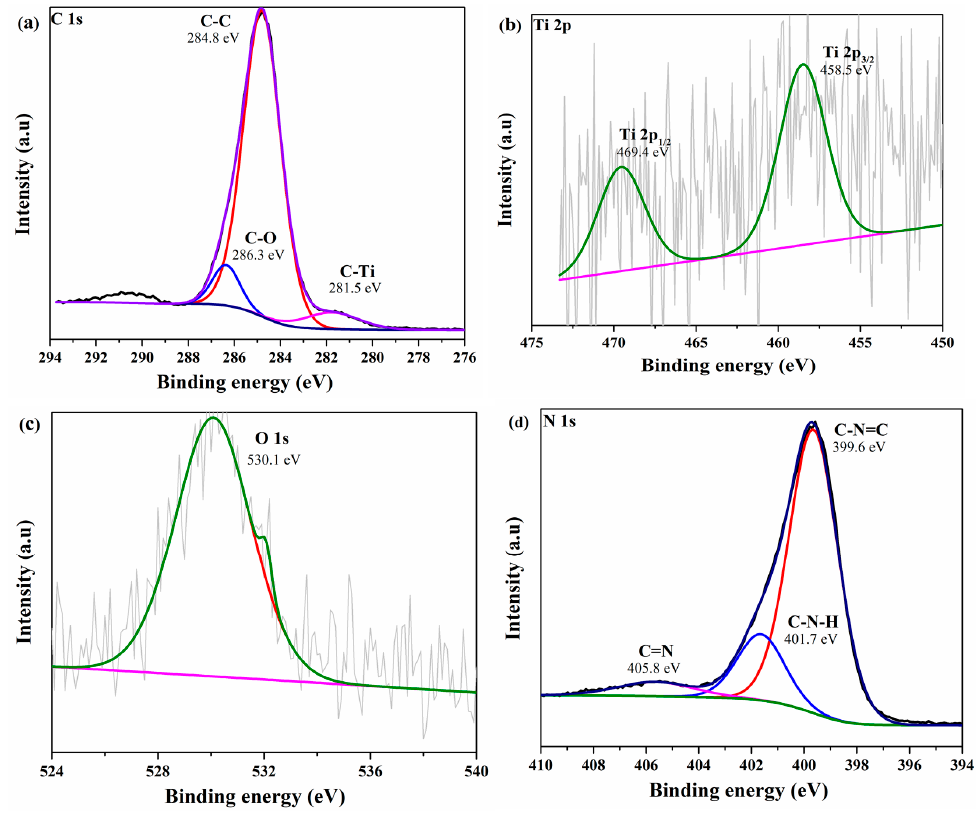
Figure 8. ( a ) C 1s, ( b ) Ti 2p, ( c ) O 1s, and ( d ) N 1s high-resolution XPS spectra of the as-synthesized 1 wt.% MXene/g-C 3 N 4 heterostructure